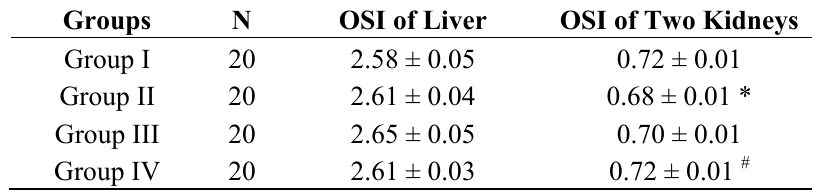
Table 2. Organo-somatic index (OSI) of liver and kidney of rats(X ± SEM, g/100 g).